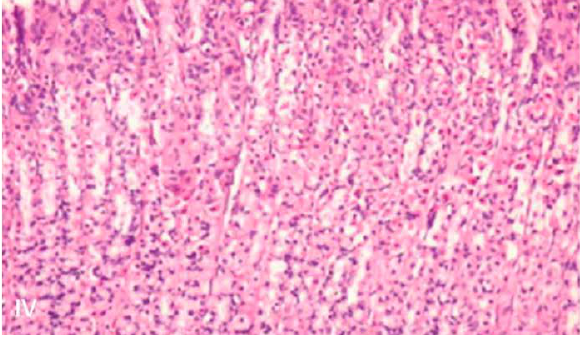
Figure 4: Typical gastric mucosa with normal appearing mucus secreting